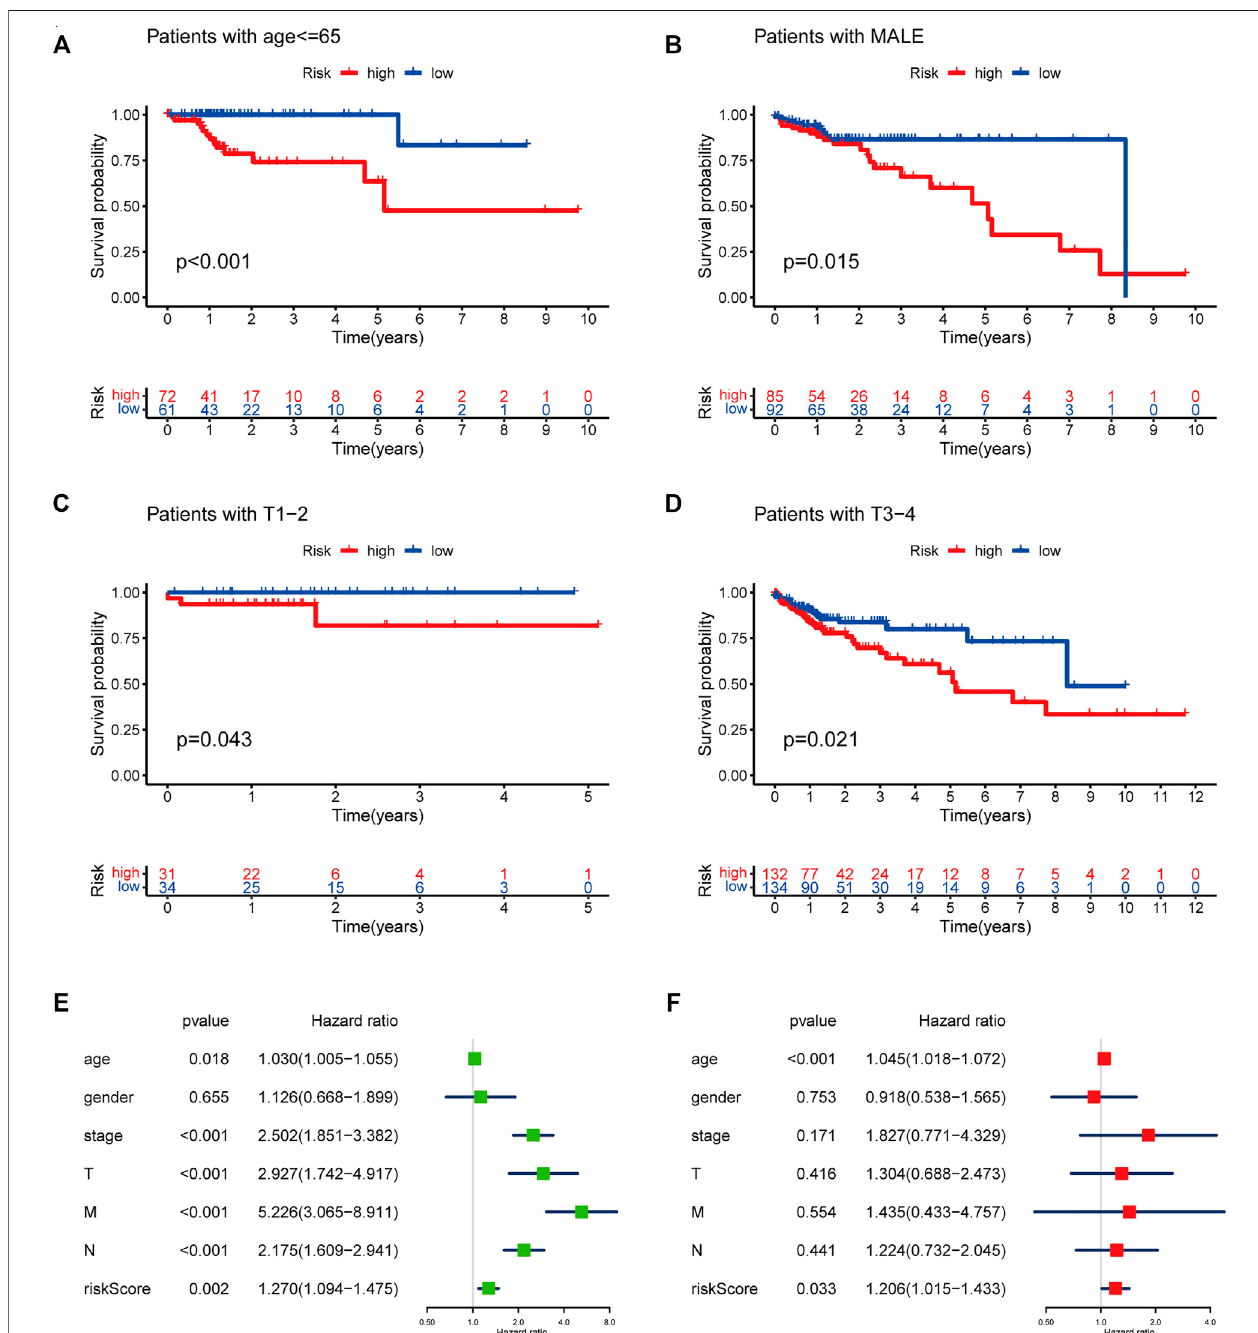
FIGURE 9 | Subgroup analysis with risk score in different clinicopathological features and Prognostic risk model veri fi cation. (A) age ≤ 65. (B) male. (C) T1-T2. (D) T3-T4. (E) UnivariateCoxregressionanalysisofriskscorecombinedwithclinicopathologicalfactors. (F) MultivariateCoxregressionanalysisofriskscorecombinedwith clinicopathological